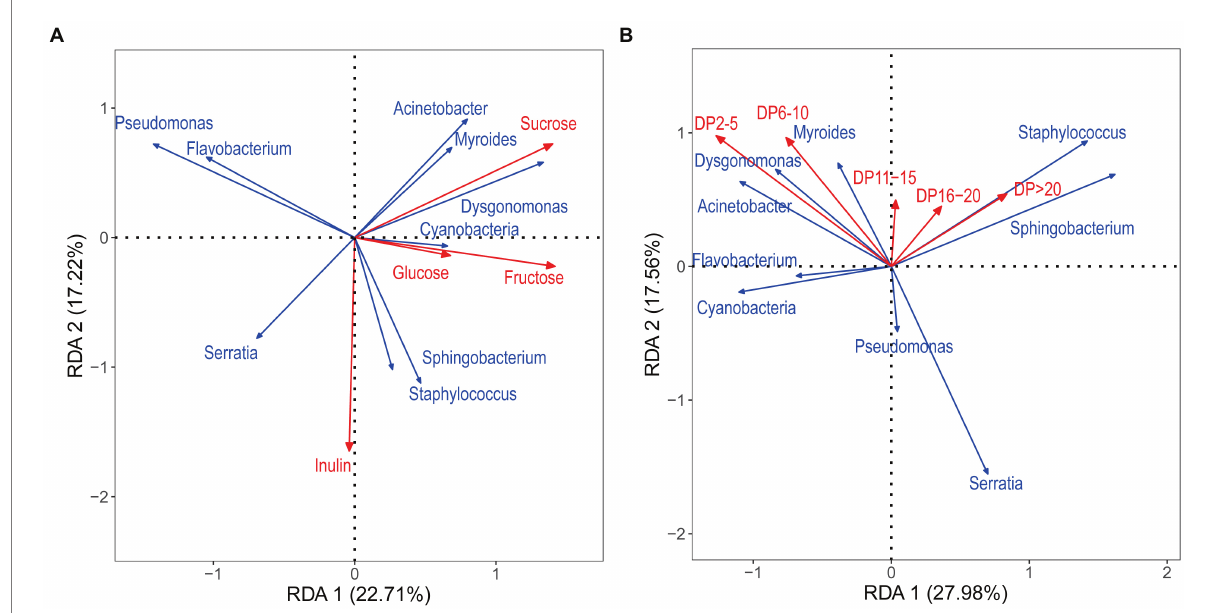
FIGURE 6 Redundancy analysis (RDA) based on bacteria OTU data with chemical parameters. ( A ): RDA between carbohydrate and bacterial communities, ( B ): RDA between the DP of inulin and bacterial communities. The correlation between carbohydrate factors and RDA axes is represented by the length and angle of